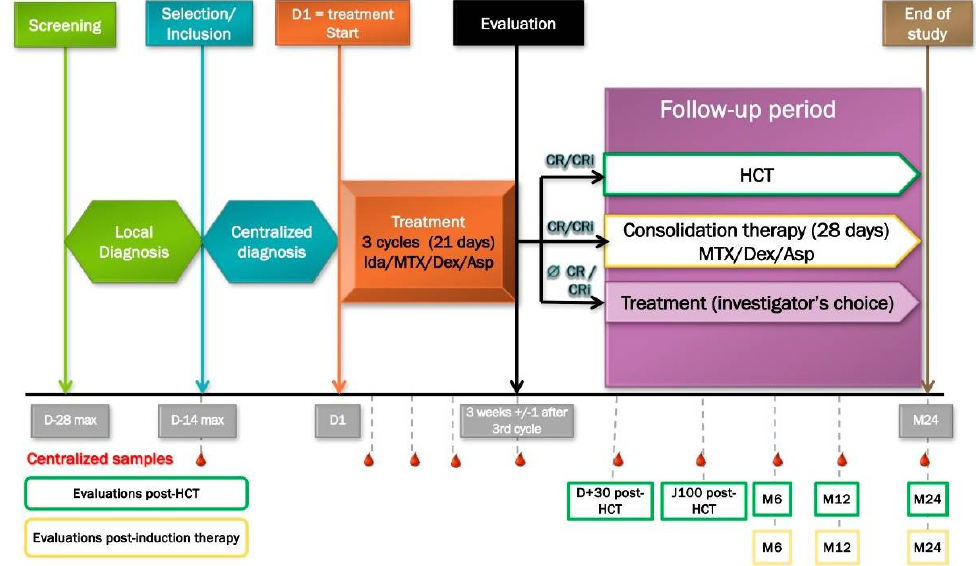
Figure 1. LpDessai clinical trial (NCT03599960) design. D, day; Ida, idarubicin; MTX, methotrexate; Dex, dexamethasone; Asp, asparaginase; CR, complete remission; Cri, complete remission with incomplete hematopoietic recovery; HCT, hematopoietic stem cell transplantation; M, month; wk, week.